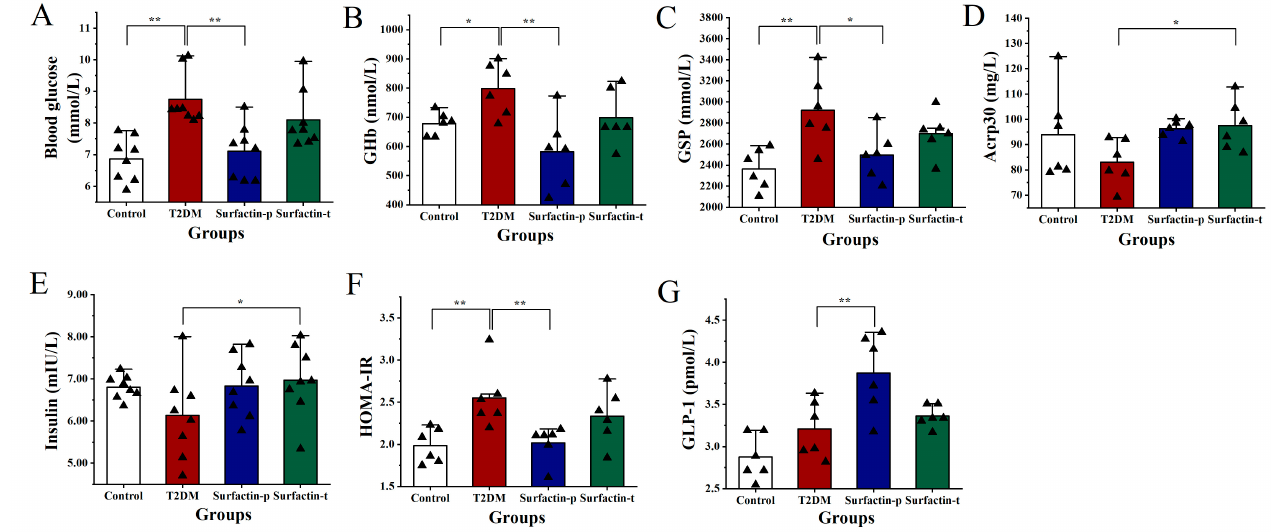
Figure 8. Effect of surfactin on critical serum parameters in HFD/STZ-induced T2DM mice. The control group represents normal mice fed a basic diet, the T2DM group represents mice with T2DM induced by a 60% fat diet and 30 mg/kg body weight STZ, the surfactin-p group represents T2DM mice treated with 80 mg/kg body weight surfactin before STZ injection, and the surfactin-t group represents T2DM mice treated with 80 mg/kg body weight surfactin after STZ injection. The serum levels of blood glucose ( A ), GHb ( B ), GSP ( C ), Acrp30 ( D ), insulin ( E ), HOMA-IR ( F ) and GLP-1 ( G ). * indicates significant differences at p < 0.05, ** indicates significant differences at p < 0.01.